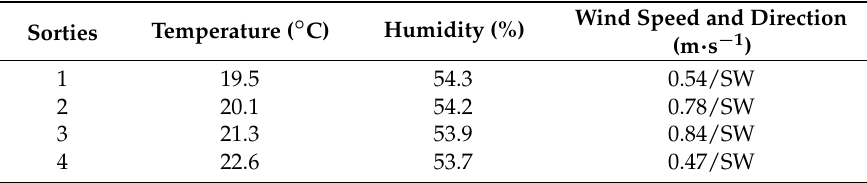
Table 3. Test environment parameter list.